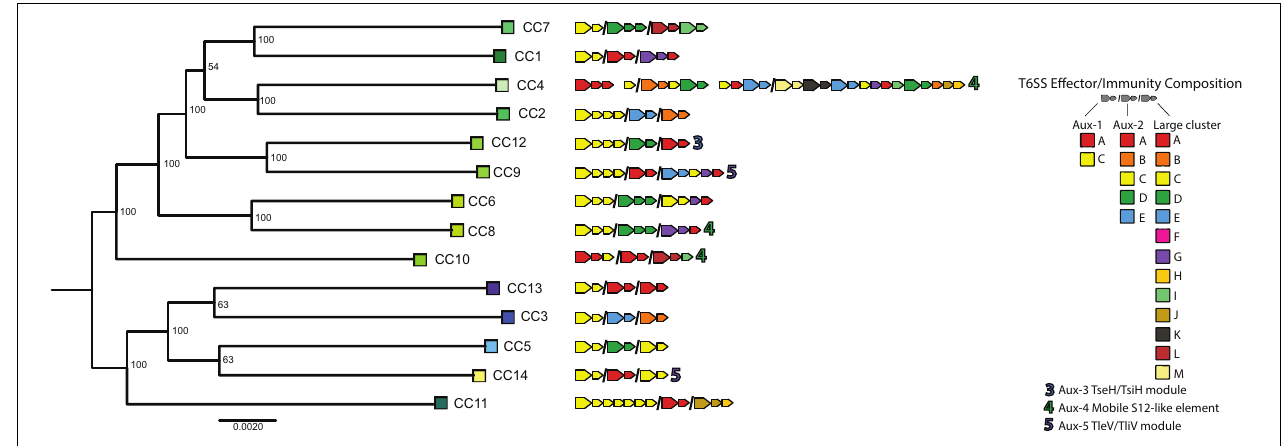
FIGURE 1 | Type VI secretion system effector and immunity genes in a Vibrio cholerae population. Representative strains of clonal complexes in the V. cholerae population of Oyster Pond (MA, United States) were typed for their T6SS gene complement. Large arrows next to strain names indicate T6SS effectors, small arrows indicate immunity genes, and color of arrows represent different effector and immunity protein coding gene families as defined by > 30% shared amino acid identity. Auxiliary clusters 1 and 2 and the large cluster genes are separated by slashes; spaces within clusters denote interruptions in canonical locus structure. Note that similarly named/colored families denote different families in different clusters. Numbers indicate auxiliary T6SS loci. Strain phylogeny was constructed from a 2,948,969-bp whole genome alignment using the GTR + GAMMA model implemented in RAxML (Stamatakis, 2014). Statistical branch support was obtained from 100 bootstrap pseudoreplicates. Tree was rooted at the